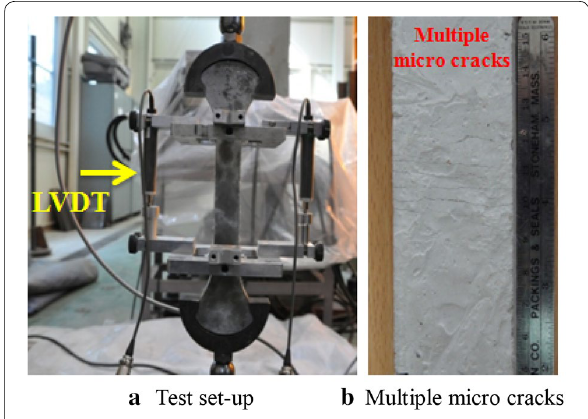
Fig. 2 Direct uniaxial tensile test.